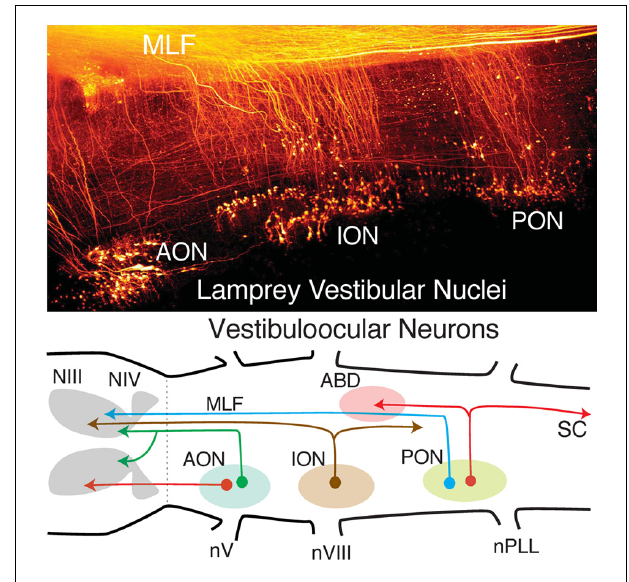
FIGURE 4 | Organization of lamprey octavolateral vestibular nuclei. Confocal image stack (top) showing retrogradely labeled vestibular neurons in three midbrain-projecting nuclei. Schematic diagram (bottom) of crossed and uncrossed vestibuloocular neurons in the anterior, inferior, posterior octavolateral nuclei (AON, ION, PON) projecting to motoneurons in the oculomotor (III), trochlear (IV), and abducens (ABD) nucleus. PON neurons (red lines) project to ABD Mns and the spinal cord (SC). Organizational scheme based on data reported by Gilland and Baker (1995) and Pombal etal. (1996). nV, trigeminal nerve; nPLL, posterior lateral line nerve; nVIII, vestibular nerve; MLF, medial longitudinal